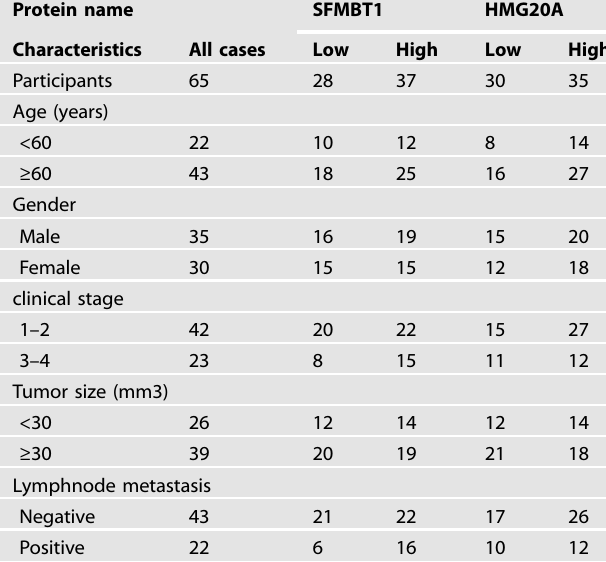
Fig. 3 SFMBT1 knockdown in mouse xenograft model reduces drug resistance and metastasis. A Xenografts derived from nude mice subcutaneously injected with the indicated cells ( n = 6). B Tumor weight of nude mice recorded every 4 days after the initial treatment. C Tumor volume after different treatments. D , E Representative images of lungs ( D ) from each group with H&E staining ( E ) of metastatic tissue sections. F The relative number of metastatic nodules were quanti fi ed. * P < 0.05. Table 1. SFMBT1 and HMG20A protein level and clinic parameters in 65 patients with colon